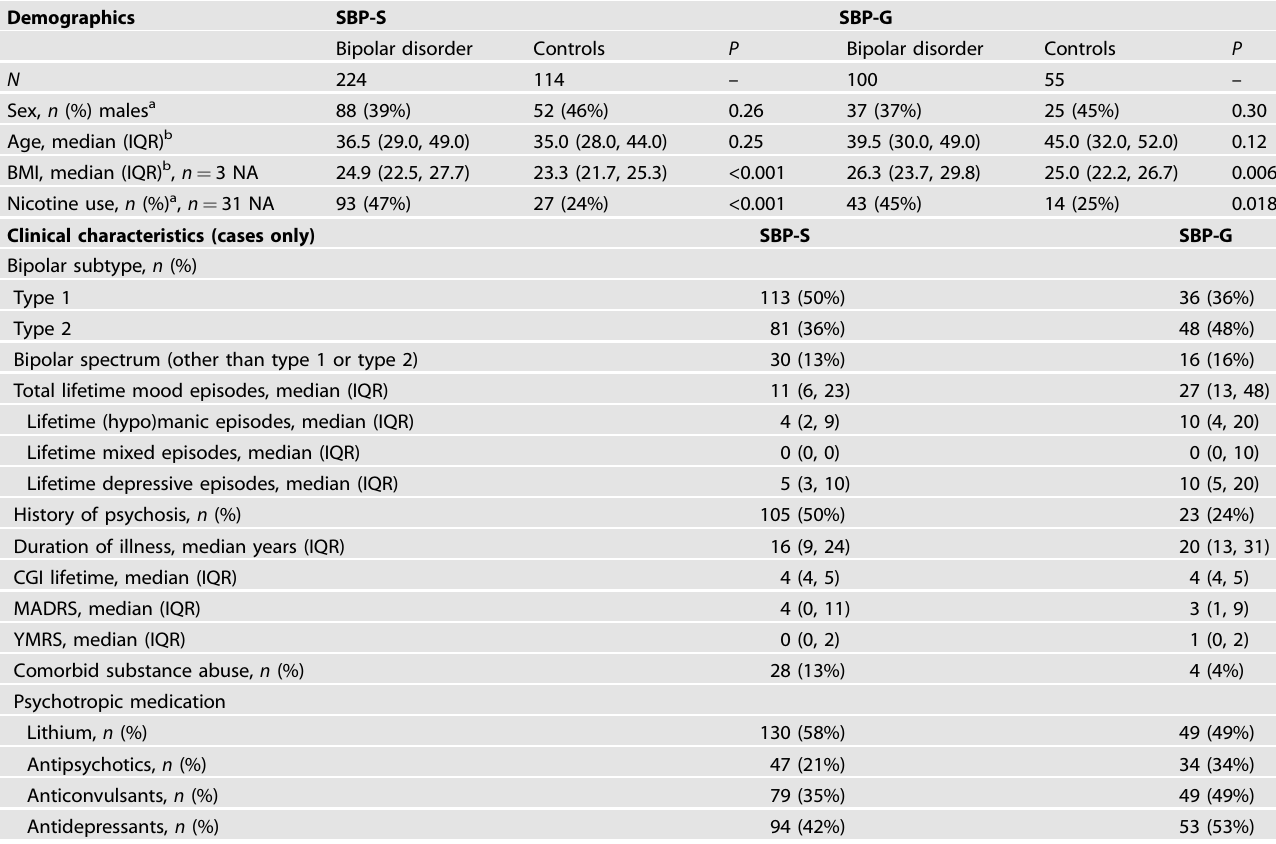
Table 1. Demographic and clinical